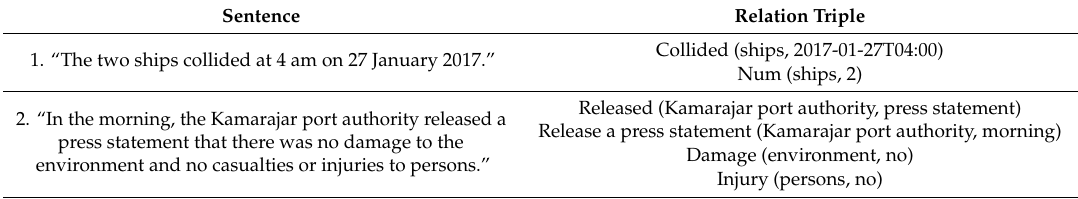
Table 4. Relation triple